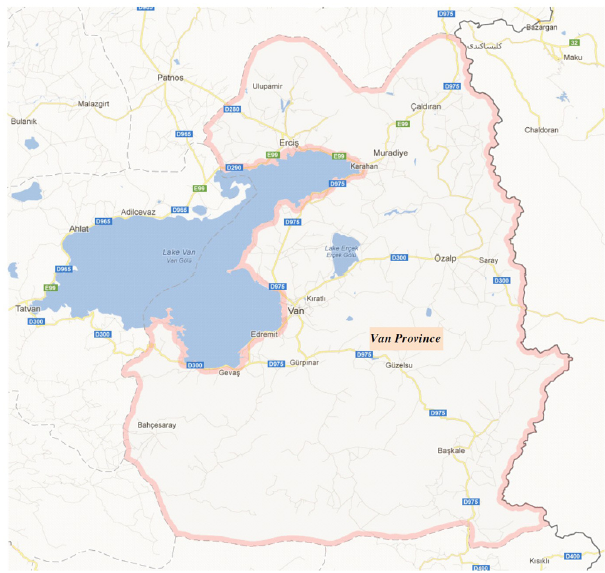
Fig. 1. Map of Van Province.